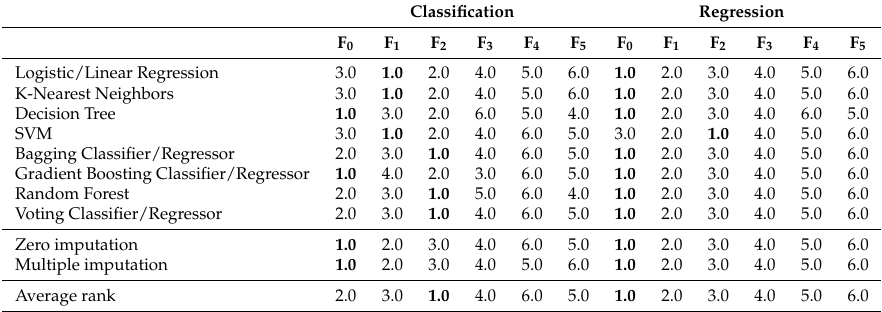
Table 11. Ranking of feature sets for different classification and regression models for target